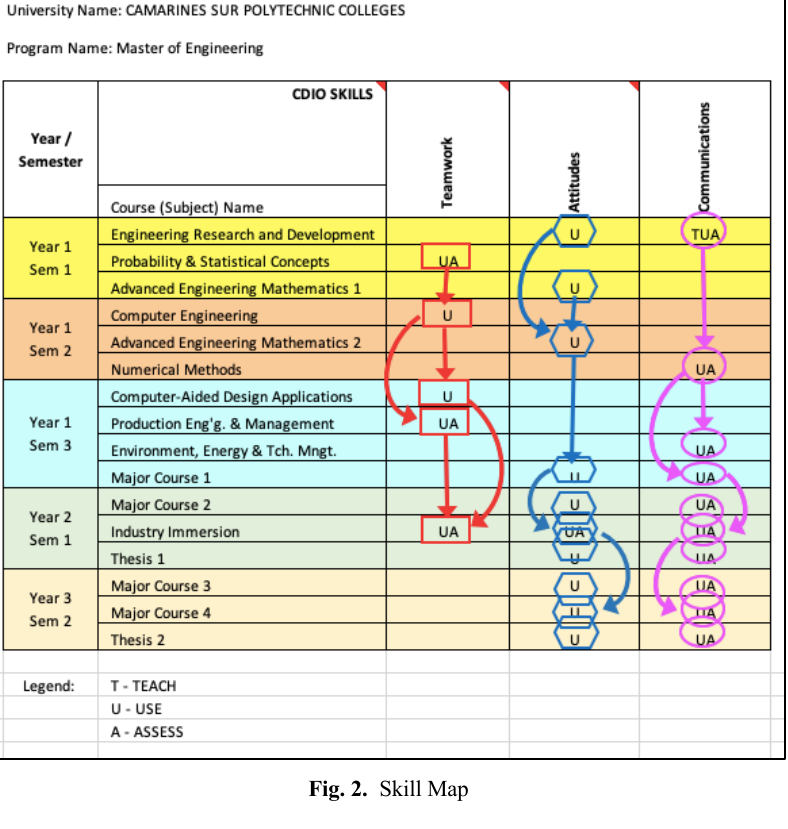
Fig. 2. Skill Map